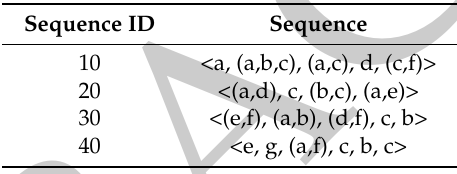
Table 1. An example of a sequence database.